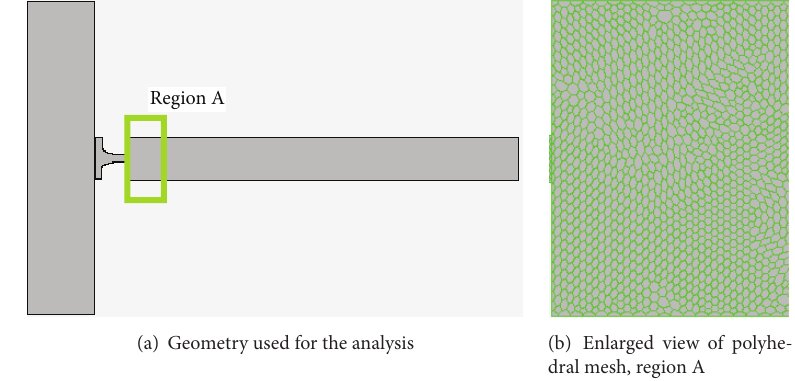
(b) Enlarged view of polyhe- dral mesh, region A